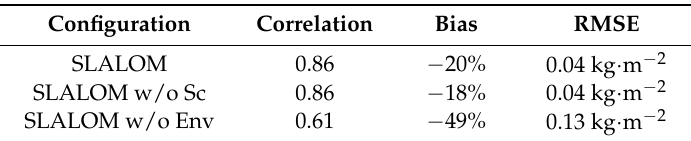
Table 2. Comparison of SWP observations from CPR, with SWP predictions for the full SLALOM algorithm (SLALOM), without taking into account supercooled droplets occurrence (SLALOM w/o Sc) and environmental conditions (SLALOM w/o